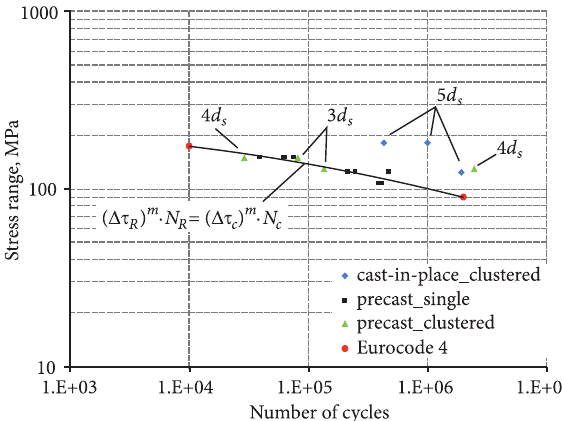
Fig. 13. Fatigue test results of clustered shear studs in